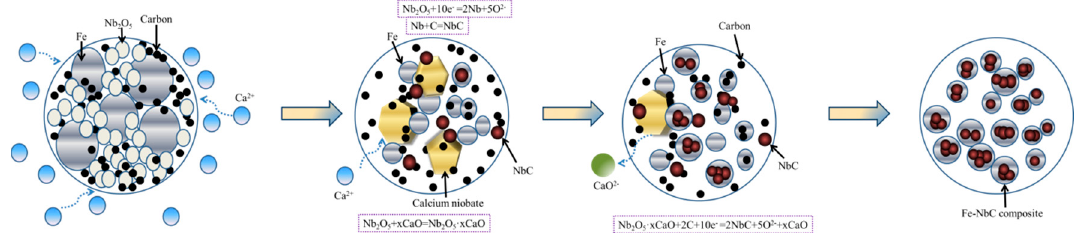
Figure 4. Schematic representation of electrochemical synthesis of the NbC–Fe composite in molten CaCl 2 –NaCl.